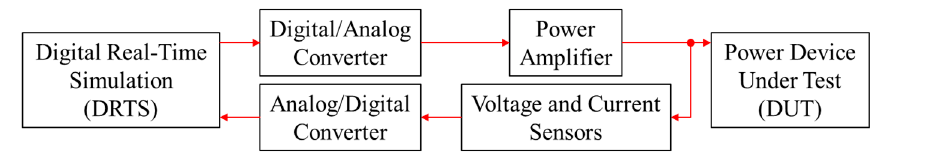
Figure 2. Test lab configuration.